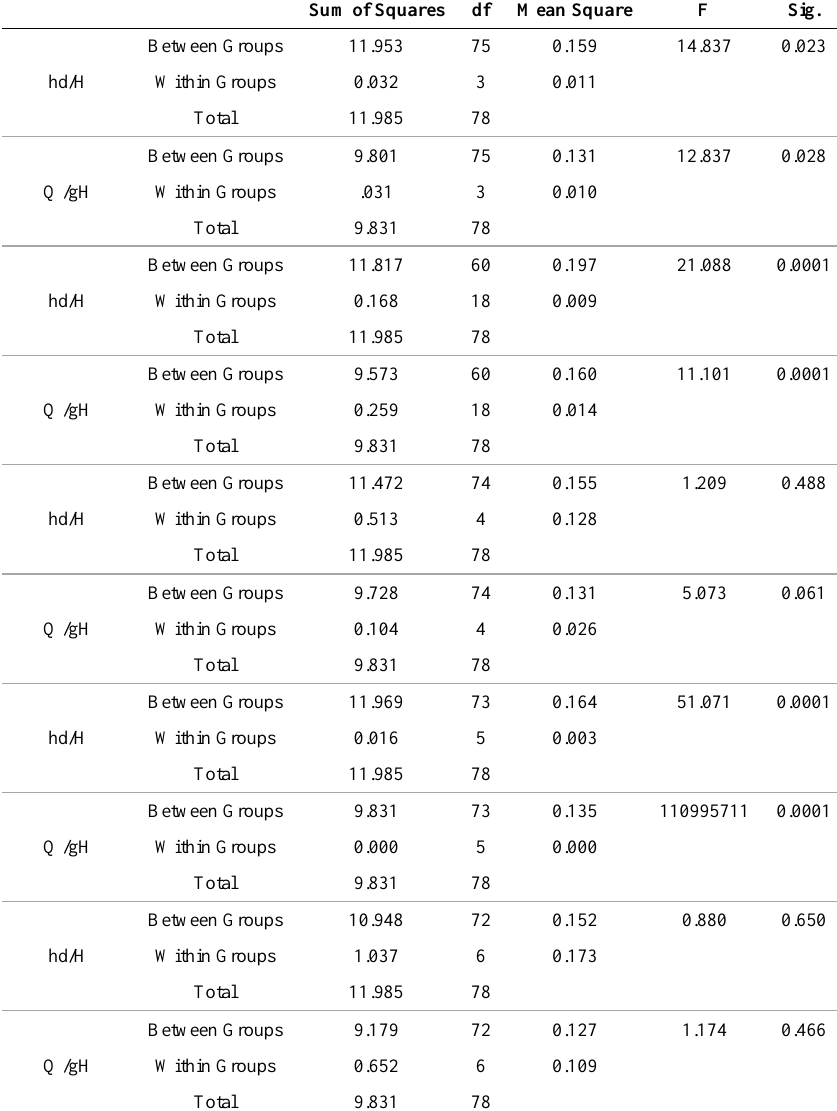
Table 4. Analysis of the independent hydraulic characteristics (h d /H and Q/gH) and dependent hydraulic characteristics (Ag/HB, y/H, R e , 𝐅𝐫 𝐮𝐩 and 𝐅𝐫 𝐝𝐨𝐰𝐧 ) respectively by